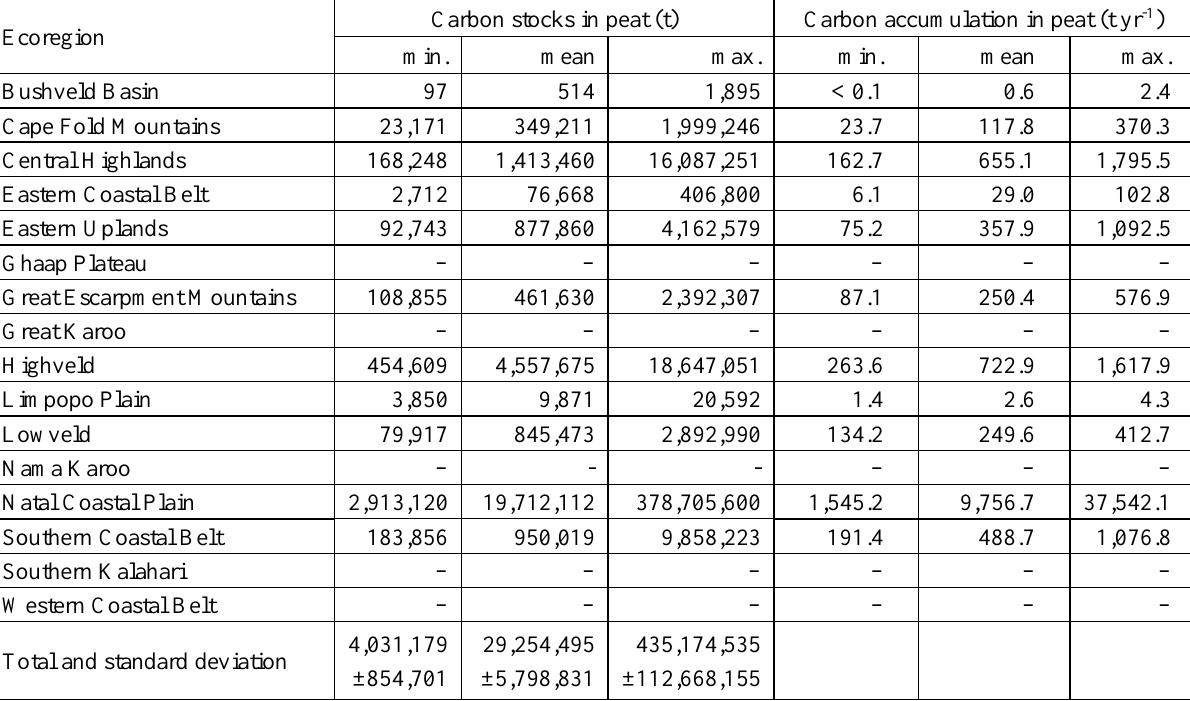
Table 3. Carbon stock range and carbon accumulation rate of peat per peatland ecoregion in South Africa (adapted from Grundling et al. 2017); min. = minimum, max. =